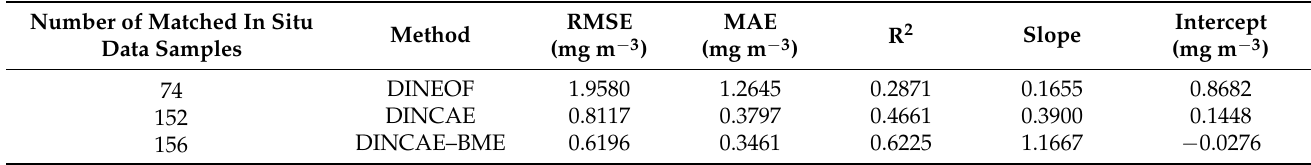
Table 5. Relationship between reconstructed values and corresponding in situ data.